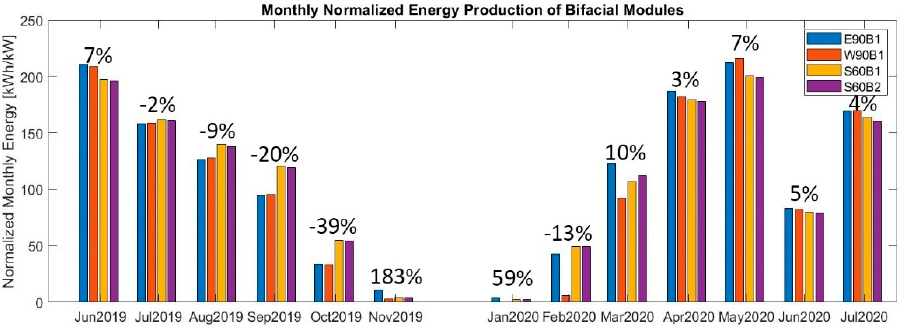
Figure 10. The normalized monthly energy production of the south-facing bifacial PV modules and the vertical east-west PV modules with the monthly vertical production gain (or loss) relative to the south-facing modules written above the monthly columns.